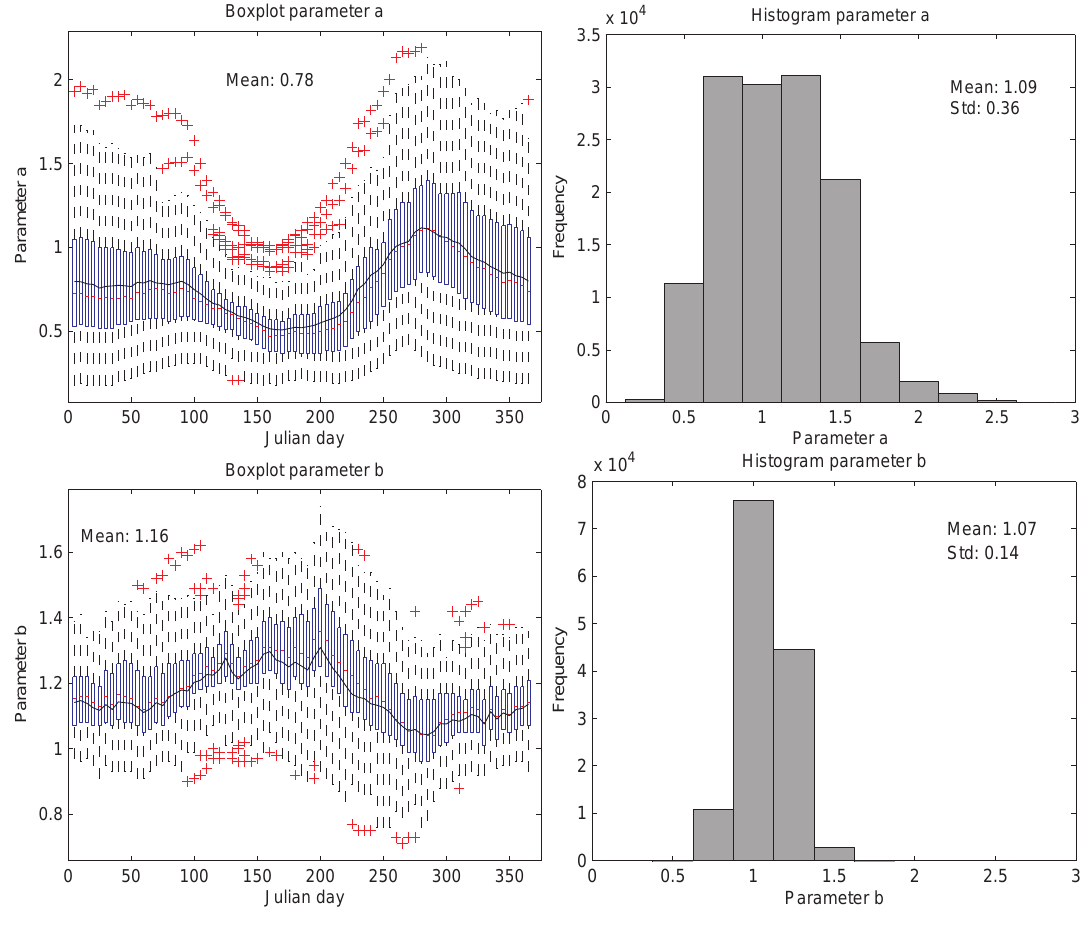
Fig. 6. Top left: boxplot for parameter a for each block of 5 days. The boxplot is calculated taking into account the values from all sub- basins. Median values are represented with the horizontal red lines. Area-weighted average parameter values are shown with the black solid line. Outliers (red crosses) are calculated as values larger than 1.5 times the interquartile range. Top right: histogram of bootstrap values for parameter a for 1000 random samples of 65 days from 17 years of data. Samples are taken from each of the sub-basins and from block 55, including 30 days before and after this block. Bottom left: boxplot for parameter b . Bottom right: histogram of bootstrap values for parameter b for block